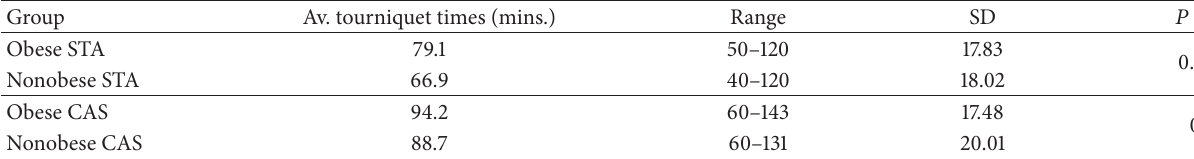
Table 2: Average tourniquet times.